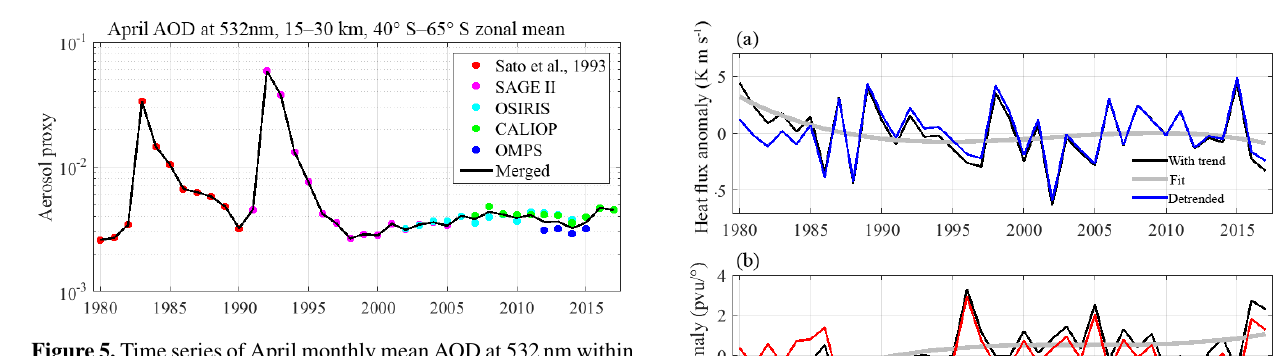
Figure 5. Time series of April monthly mean AOD at 532nm within 40–65 ◦ S and 15–30km of normalized Sato et al. (1993) dataset (see main text) and from satellites (SAGE II, OSIRIS, CALIOP, OMPS). The corresponding merged data are represented by the bold line.